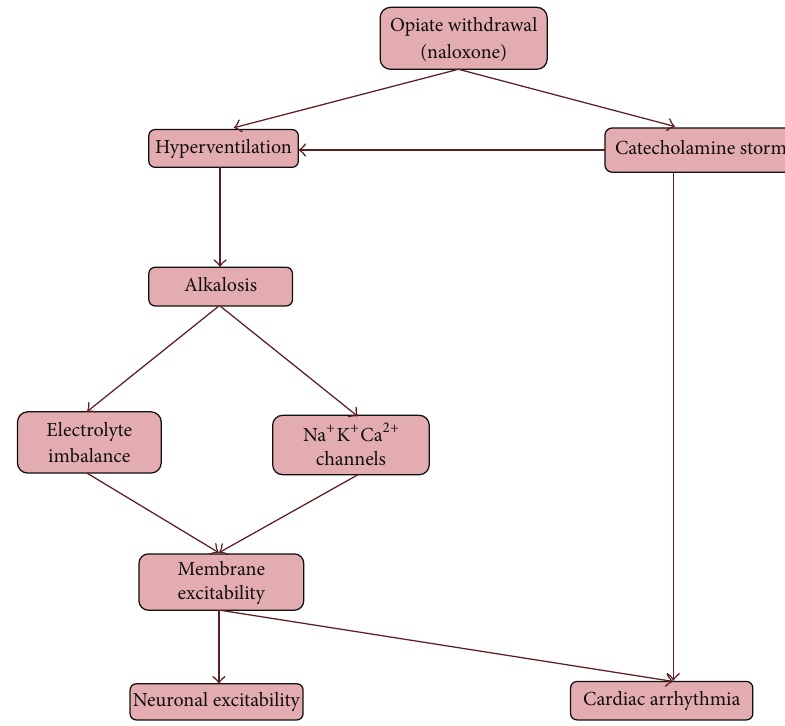
Figure 2: Mechanism explaining neuronal and cardiac excitability in opiate